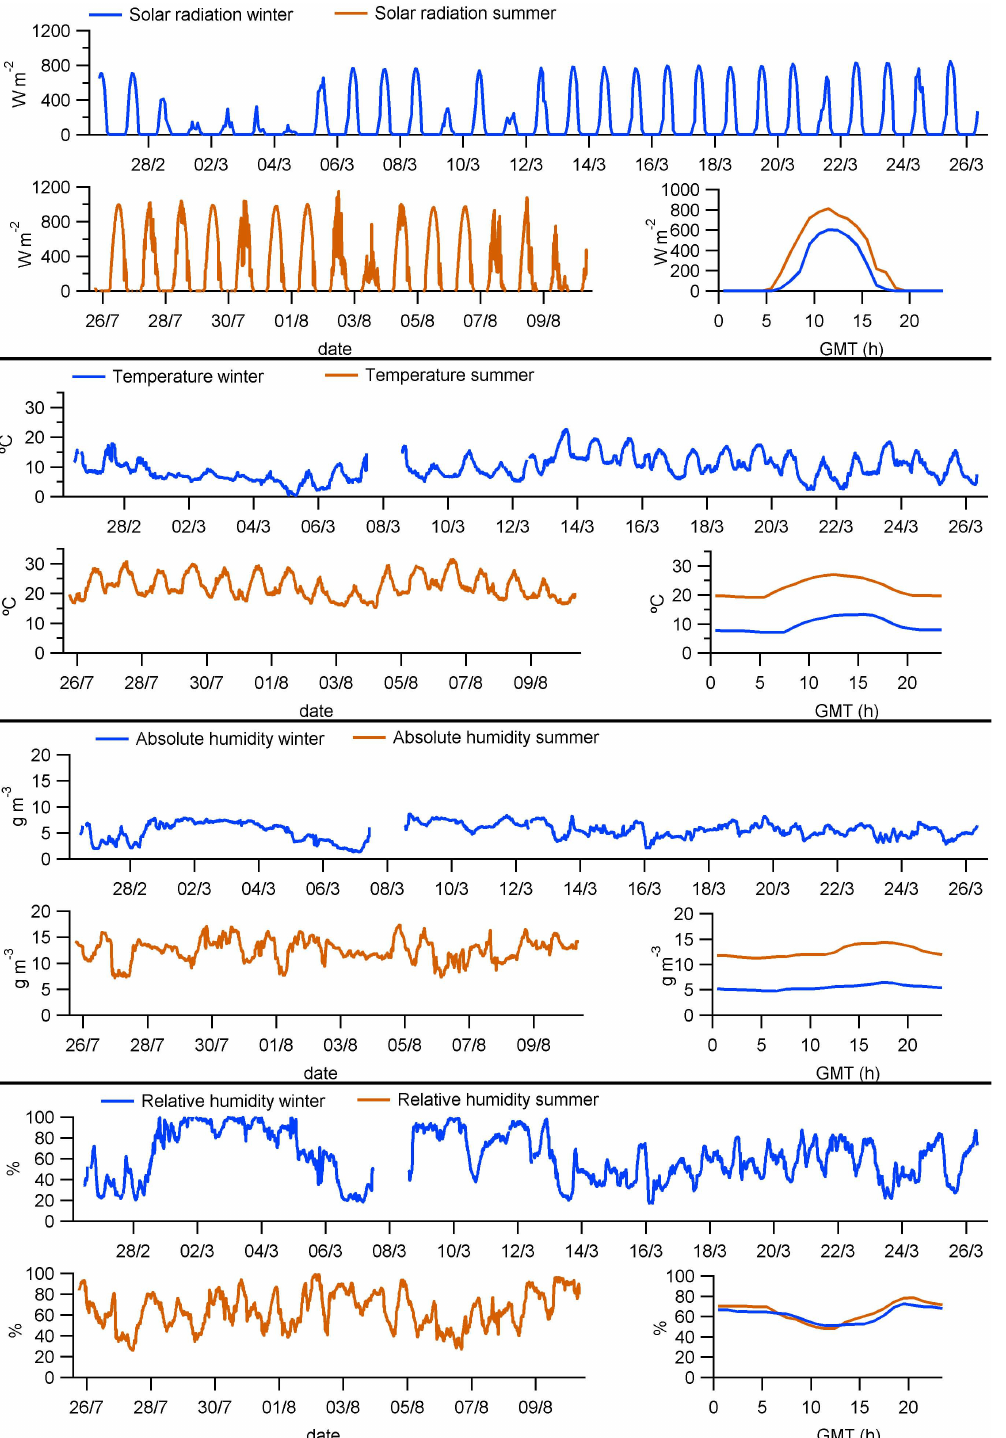
Fig. 2. Solar radiation, temperature, and absolute and relative humidity during the winter period (upper graph of each panel), during the summer period (lower left graph) and their mean daily cycles (hourly averages) for both periods (lower right graph). Date labels indicate 00:00